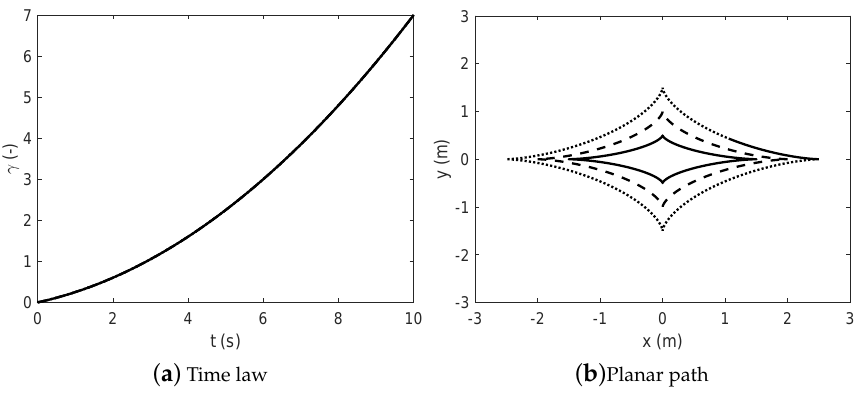
Figure 3. Robot trajectory. Initial conditions 1 (solid lines), initial conditions 2 (dashed lines), initial conditions 3 (dotted lines).